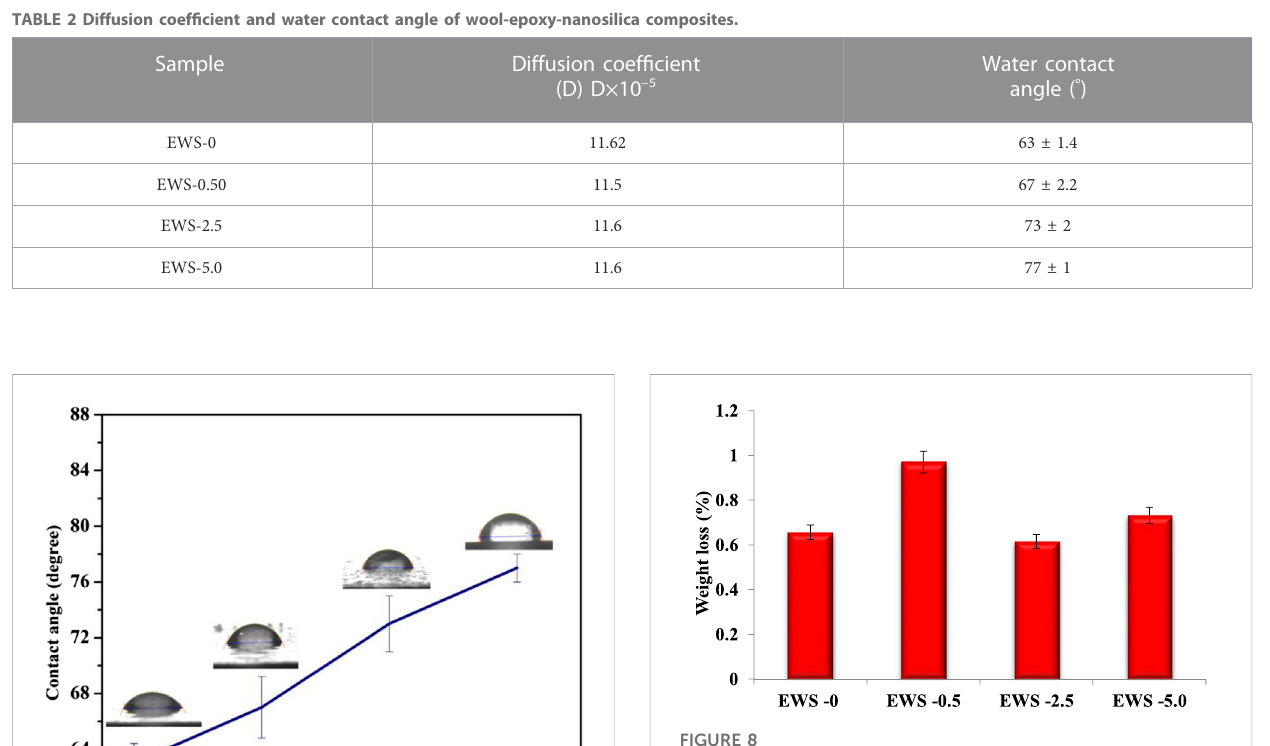
FIGURE 8 Weight loss of wool-epoxy-nanosilica composites during accelerated soil burial